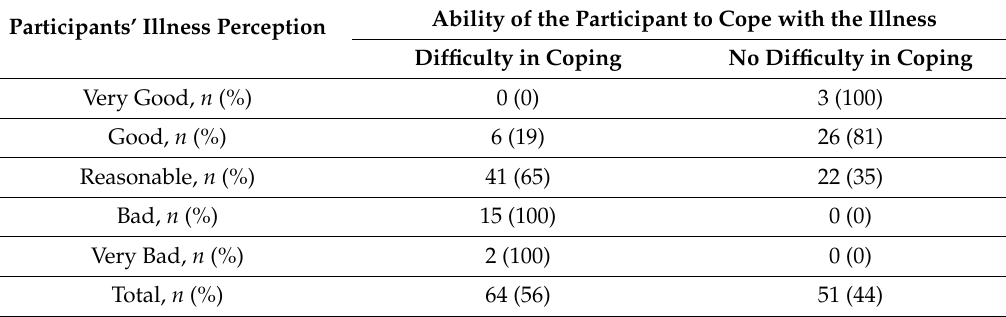
Table 3. Comparison of illness perception and coping capacity of participants.